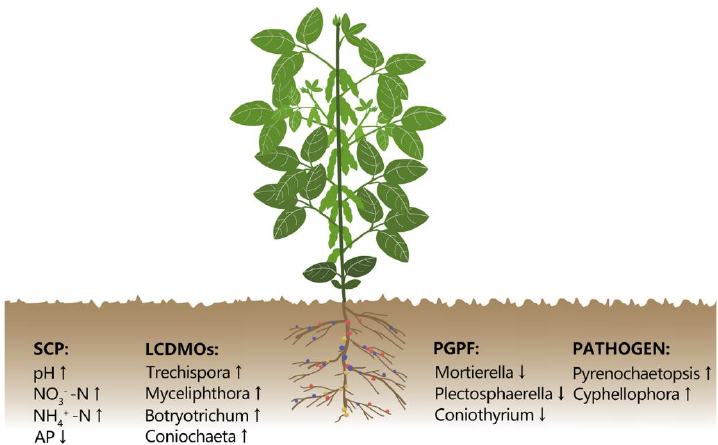
Figure 8. A conceptual paradigm explaining how long-term continuous wheat/soybean cropping influences rhizosphere soil chemical properties and microbial community. SCP: soil chemical prop- erties; LCDMOs: lignocellulose degrading microorganisms; PGPF: plant growth-promoting fungi; PATHOGEN: plant pathogens. Supplementary Materials: The following supporting information can be downloaded at: www.mdpi.com/xxx/s1, Figure S1: The FunGuild analysis of fungal community in the rhizosphere soils.; Figure S2: Relative abundance of lignocellulose-degrading fungi in two cropping systems. W/S, continuous wheat/soybean cropping system; W/S-W/M, wheat/soybean-wheat/maize rotation system; Figure S3: Histogram of the linear discriminant analysis (LDA) scores. Taxa enriched in W/S are shown in red and W/S-W/M in blue; Table S1: Relative abundances of the fungal phyla and